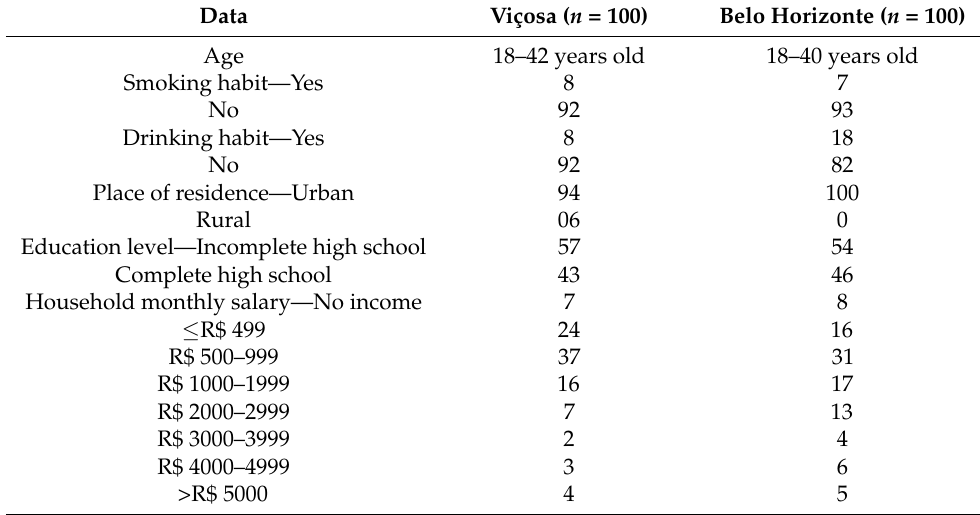
Table 1. Characteristics of the study